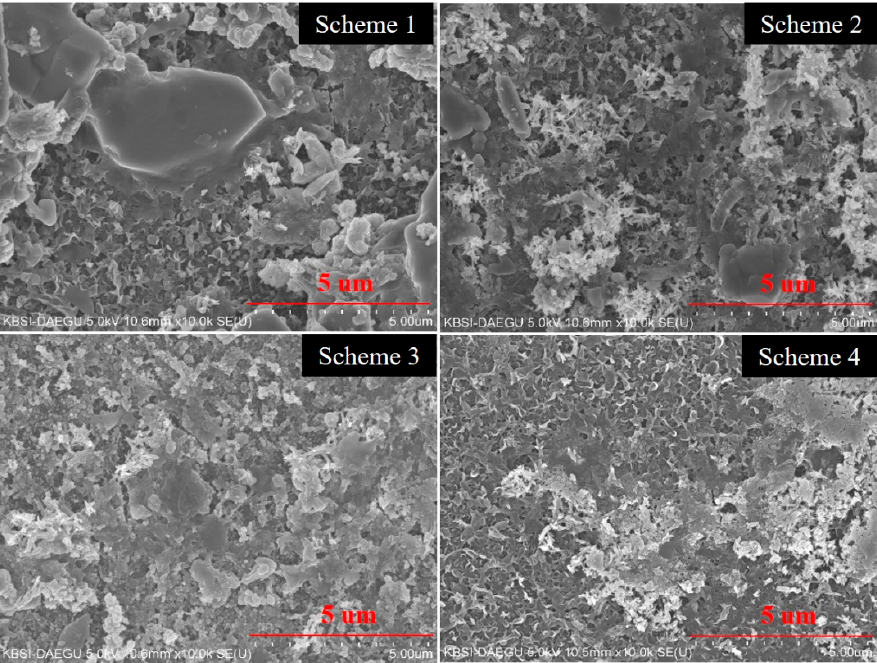
Figure 5 . SEM of the fouling deposits on the surface of membranes used in Schemes